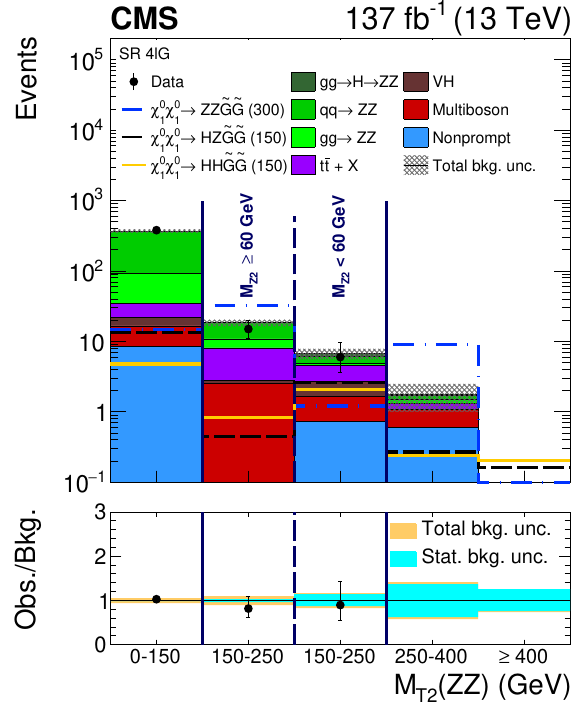
Figure 13 . Observed and expected yields across the search regions in events with four light leptons, including 2 separate OSSF pairs (4 ‘ G). Several signal models are shown superimposed. They correspond to Higgsino pair production with decays to ZZ (blue dotted line, Higgsino mass of 300 GeV), HZ (black dashed line, Higgsino mass of 150 GeV), and HH (dark yellow line, Higgsino mass of 150